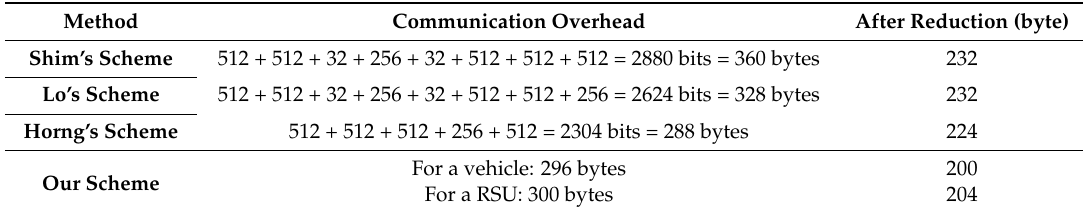
Table 6. Comparison of communication costs.